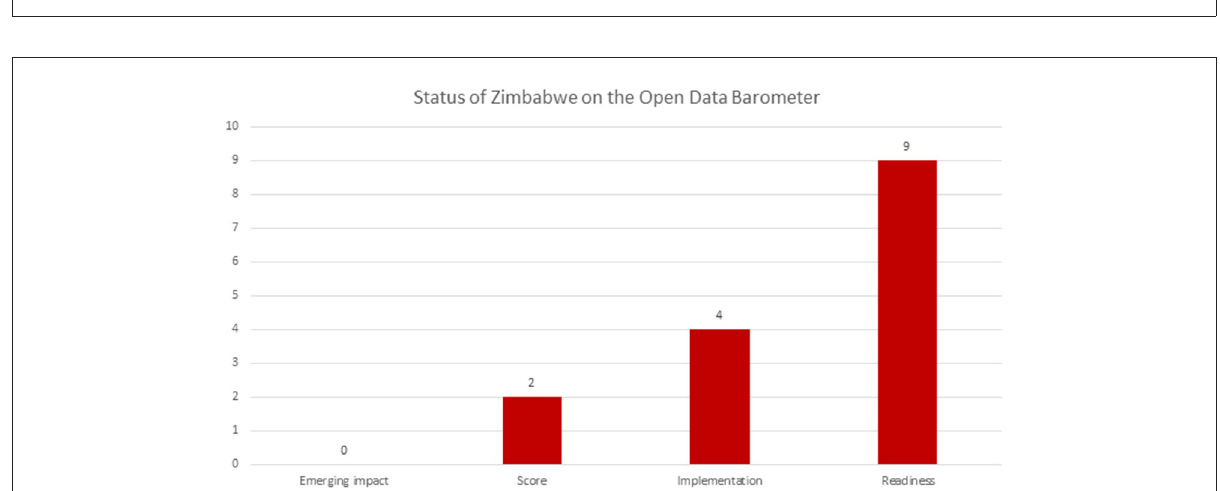
FIGURE3 Status of Zimbabwe on the Open Data Barometer–Data Source, Web Foundation (2018c).